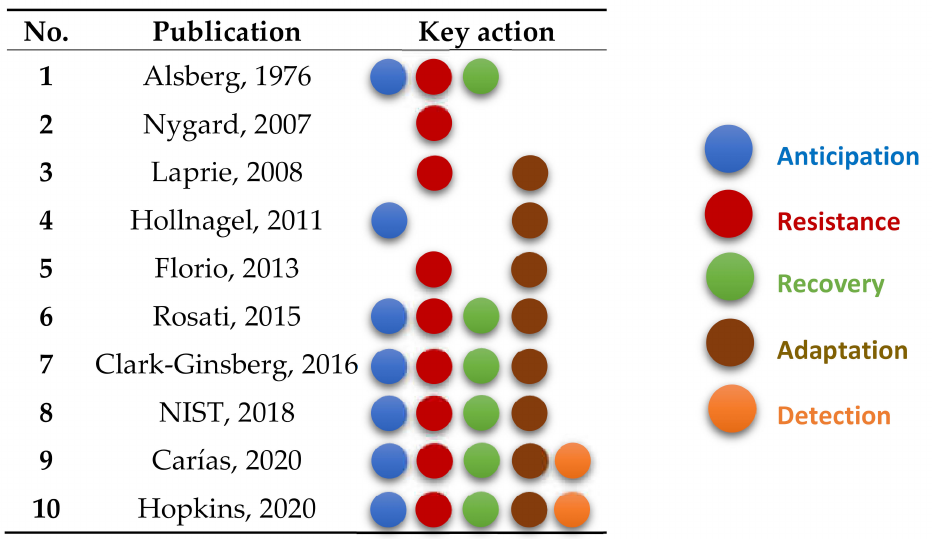
Table 2. Sources mentioning key